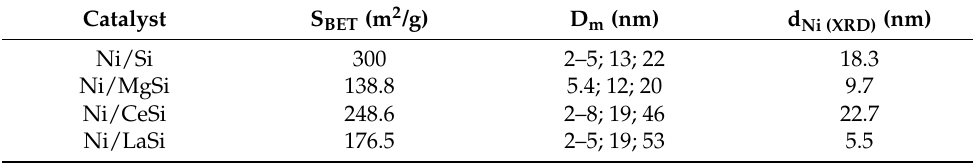
Table 3. The characteristics of catalysts used in the CO 2 methanation reaction (6 h TOS). Catalyst S BET (m 2